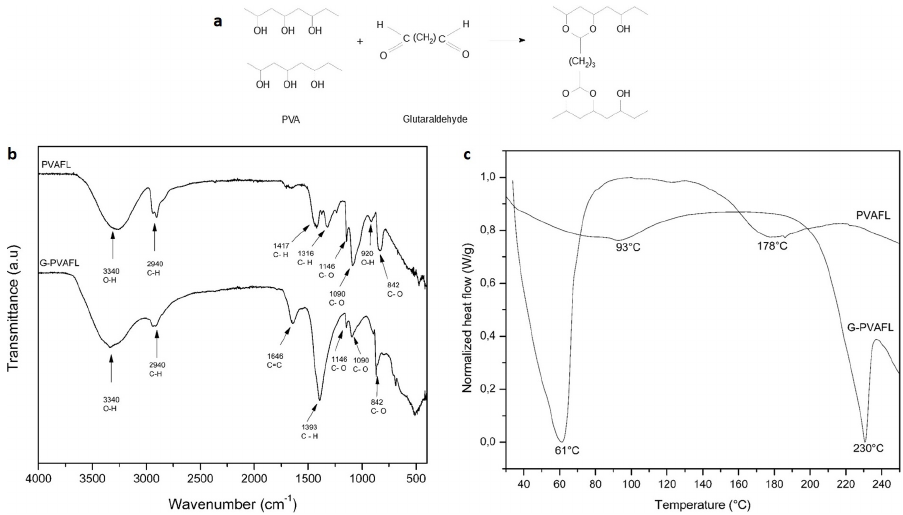
Figure 1. a. Cross-linking reaction with glutaraldehyde; b. FTIR spectra of PVAFL and G-PVAFL; c. DSC curves of PVAFL and